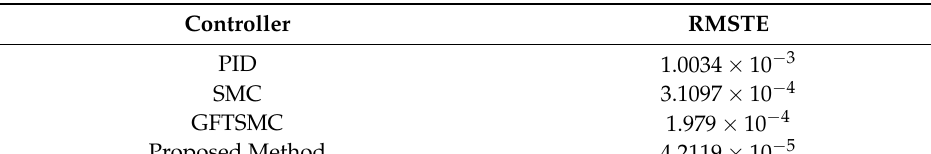
Table 3. RMSTE using the four separate controllers.